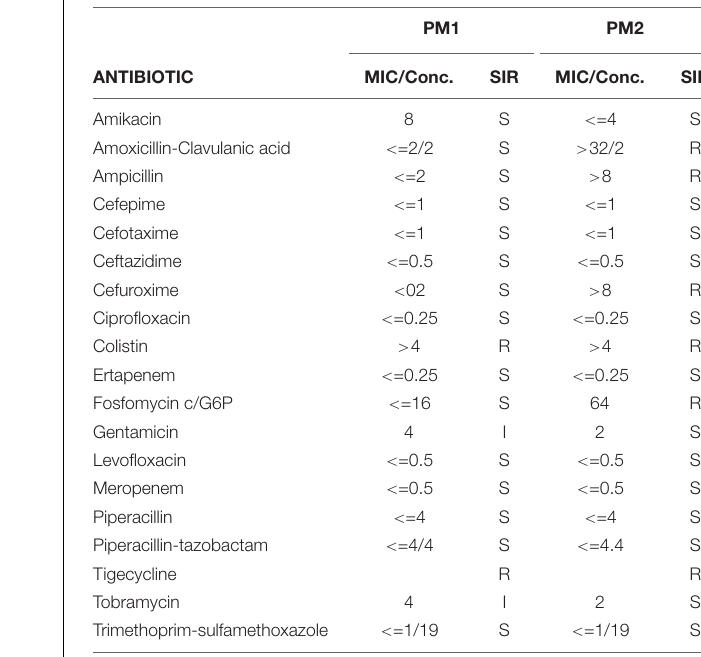
TABLE 3 | Antimicrobial susceptibility profiles of PM1 and PM2 isolates when interpreted using Phoenix TM (BD diagnostic systems).